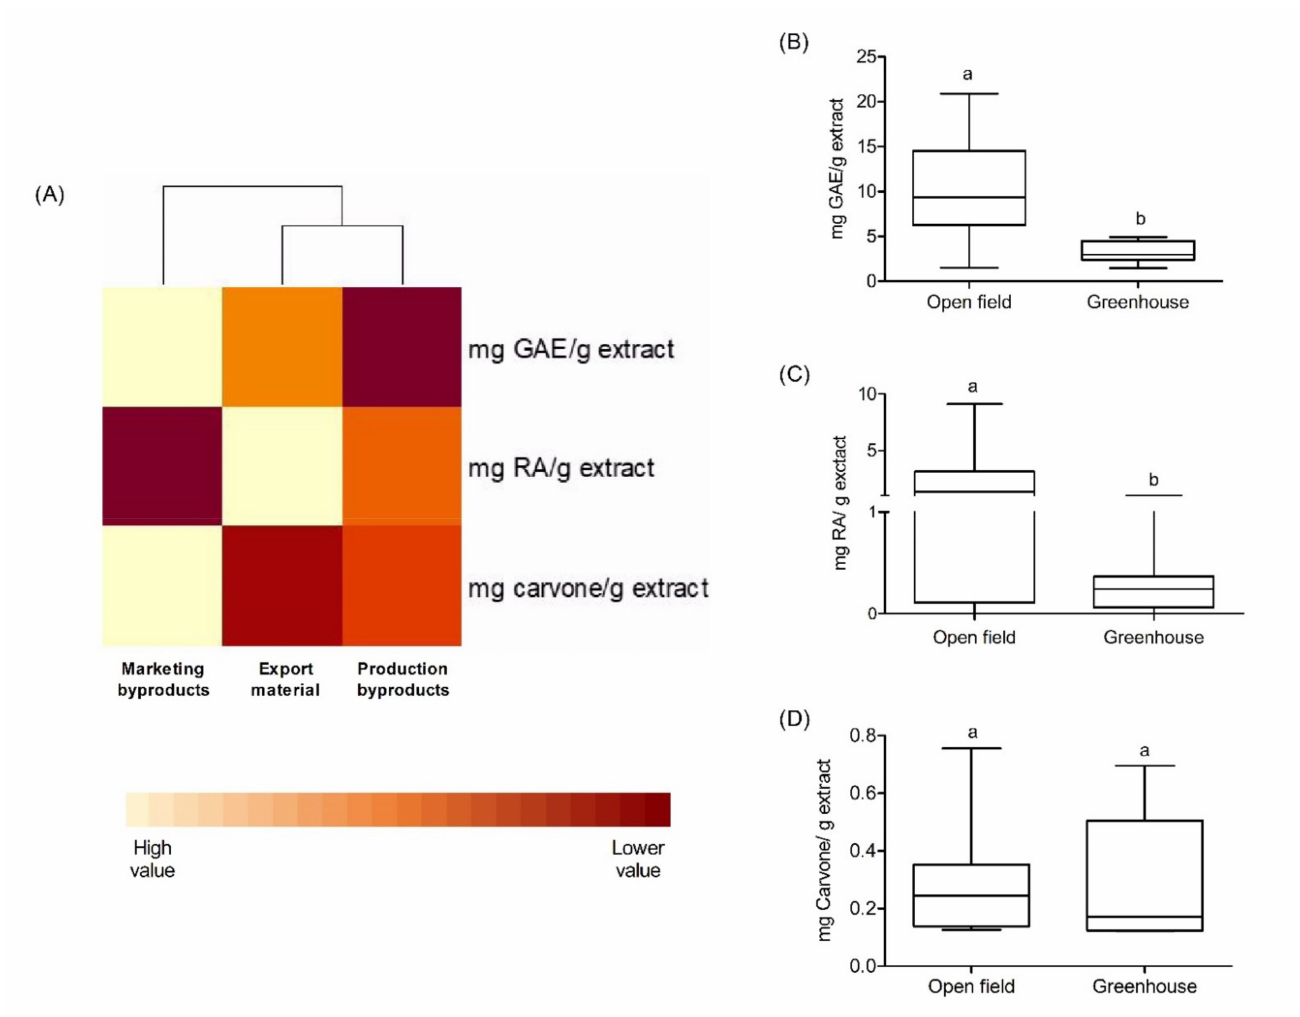
Figure 2. Heatmap of comparative analysis of byproducts and export material in the expression of GAE, RA and carvone ( A ). Box and whisker plots of the comparison of the open field and greenhouse in relation to the total phenolic content ( B ), rosmarinic acid ( C ), and carvone ( D ). Statistical analysis used one-way ANOVA (Bonferroni test, p < 0.05). Equal letters indicate that there is no statistically significant